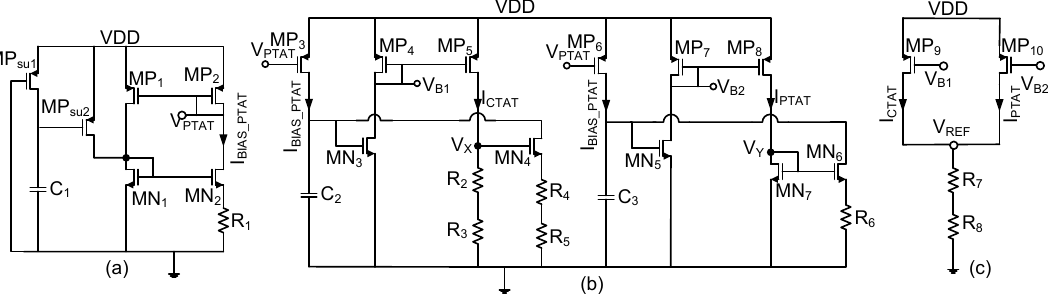
Figure 1. Schematic of the proposed voltage reference (VR1) [51]. ( a ) Proportional to absolute temperature (PTAT) current generator including a start up circuit, ( b ) main module utilizing the proposed novel method of high-order curvature correction of the reference voltage, ( c ) reference voltage output which sums the PTAT and complementary to absolute temperature (CTAT) curvature corrected